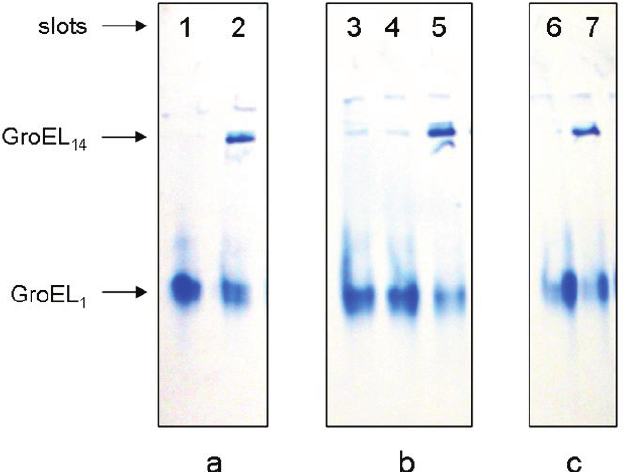
Figure 3. Nondenaturing gel-electrophoresis of folded GroEL monomers incubated before applying to the gel during 180 min at 20 – 22 °C: ( a ) in the presence of 2 M NaCl or KCl (slot 1), 2 M NaCl or KCl and 10 mM ATP (slot 2); ( b ) in the presence of 20% glycerol (slot 3), 20% glycerol and 10 mM ATP (slot 4), 20% glycerol and 10 mM MgCl ( c ) in the presence of ammonium sulfate: 100 mM (slot 6) and 1 M (slot 7). The concentration of folded monomers in incubation mixtures was 0.4 mg/mL. Buffer — 20 mM Tris-HCl, pH 7.5, 5 mM β ME.